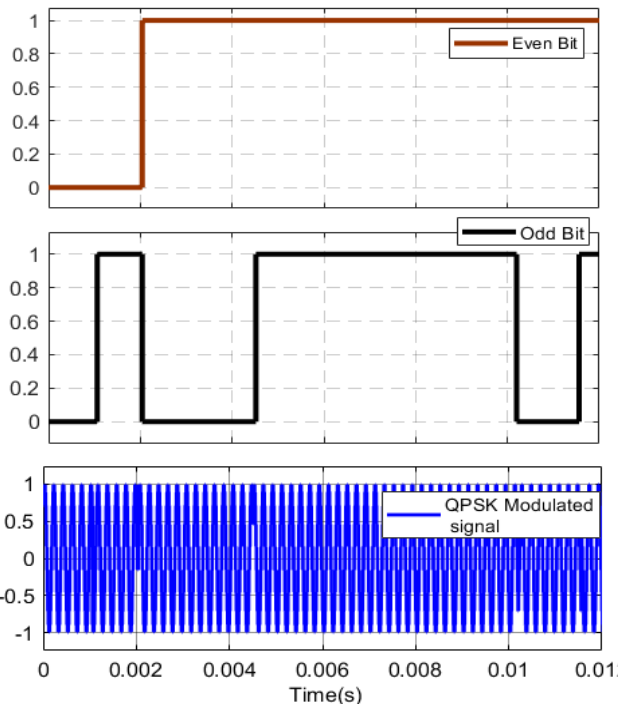
Figure 9. Binary bits and QPSK modulated signal waveforms. Figure 10 illustrates the original message signal (red) and its scaled down version (black) to 3 V. The scaled down signal is transmitted to the PLC system and recovered using the QPSK